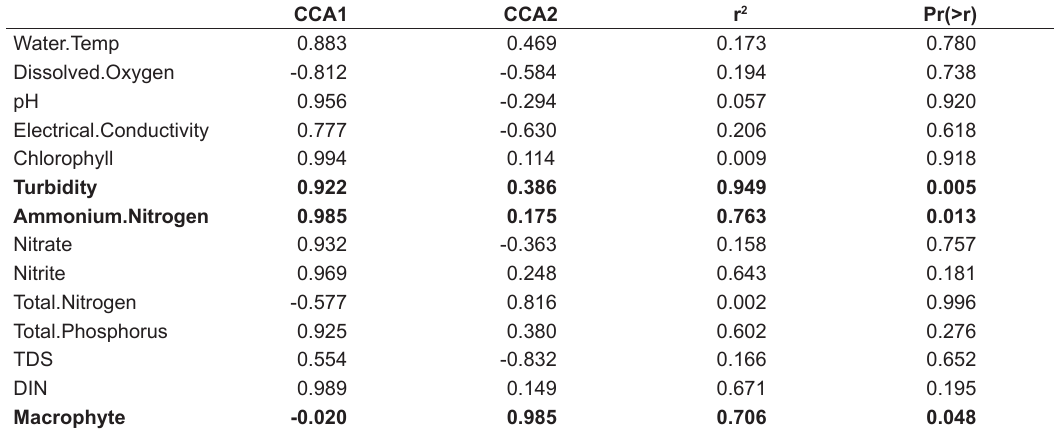
Table 2. Statistical significance of the correlation between the environmental features and biotic variables extracted from the CCA1 and CCA2 vectors of the Monte Carlo test. Significant values in